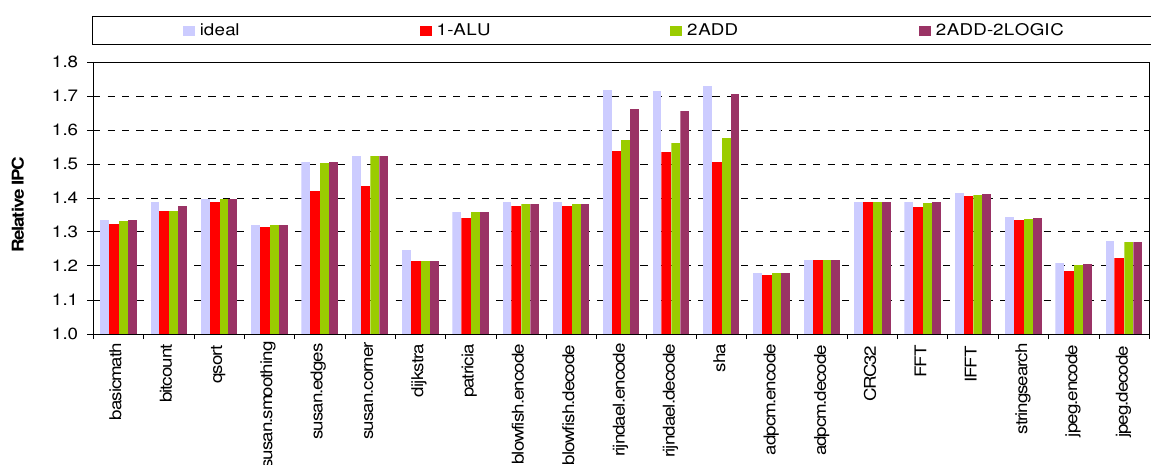
Figure 16. IPC results for a dual issue processor relative to the IPC of a single issue processor using a static branch predictor with an always taken heuristic under different ALU configurations. The ideal case is for a processor with two complete ALU